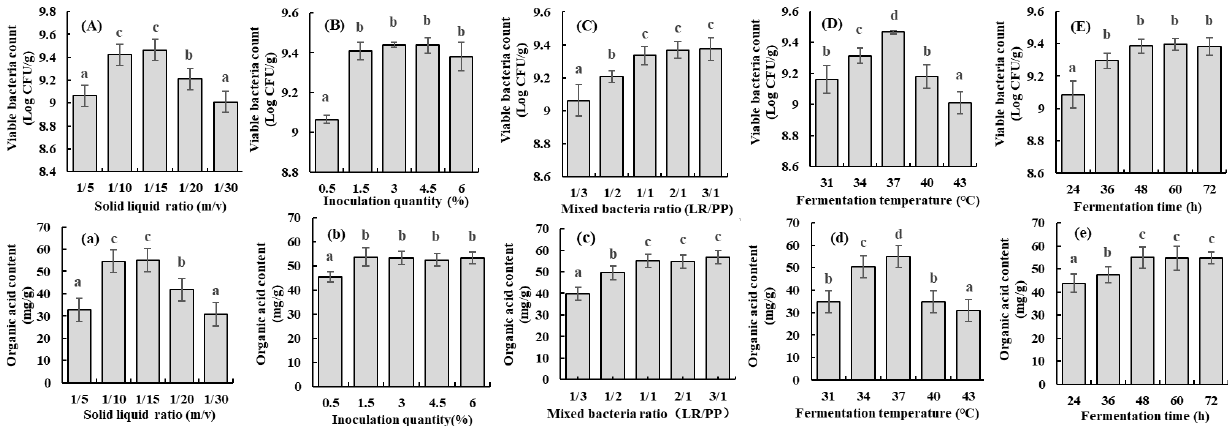
Figure 1. ( A – E ): The viable bacteria counts of sweet potato residues fermented with combined strains under different fermentation parameters; ( a – e ): The organic acid content of sweet potato residues fermented with combined strains under different fermentation parameters; Lowercase letters above each bar chart indicates significant differences ( p < 0.05).